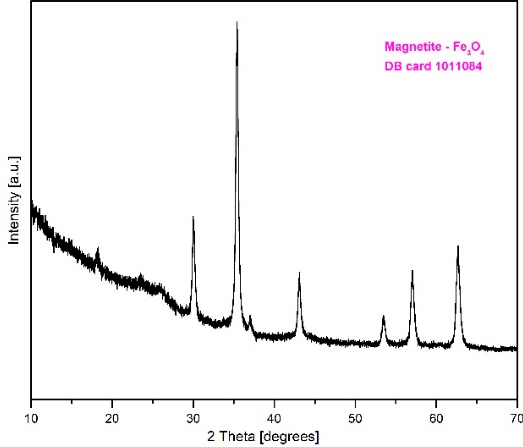
Figure 1. XRD pattern of the Fe 3 O 4 @C matrix prepared by combustion synthesis.